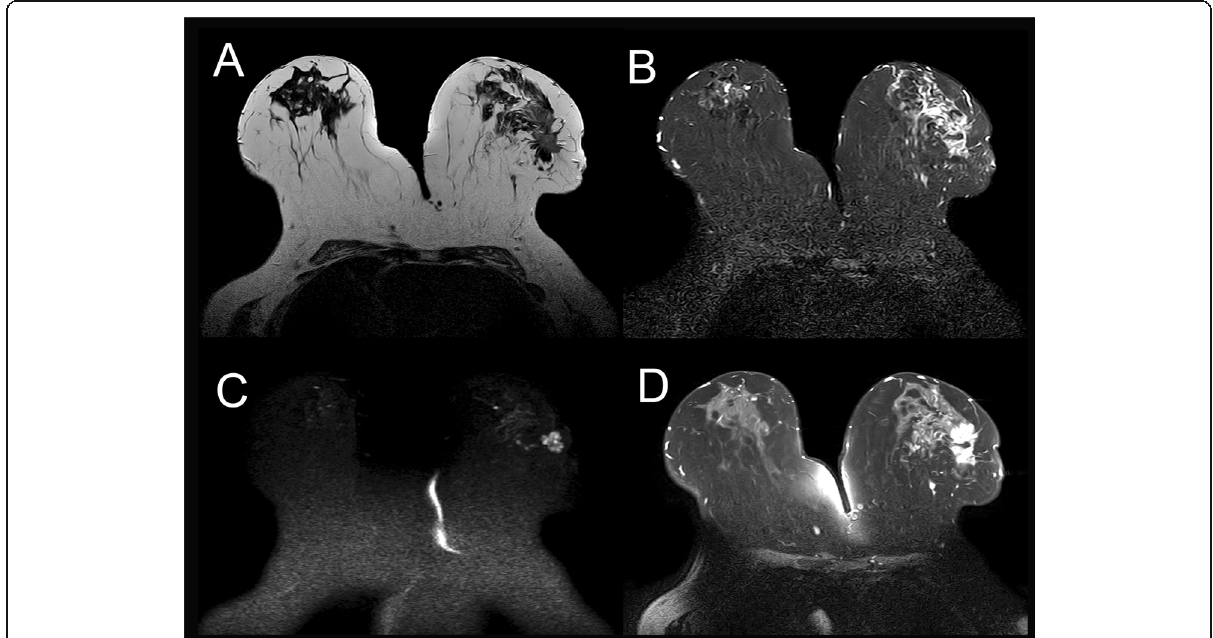
Fig. 5 In the left breast, a lobulated mass lesion of spiculated margin was noted. It exhibited intermediated SI in T2WI ( a ), high in STIR ( b ), and restricted in DWI ( c ). The ADC value was 0.7 × 10 − 3 mm 2 /s. Intense enhancement was noted in post-contrast scan ( d ) and the kinetics curve was of type 3. This was agreeing with biopsy result which asserted it was lobular